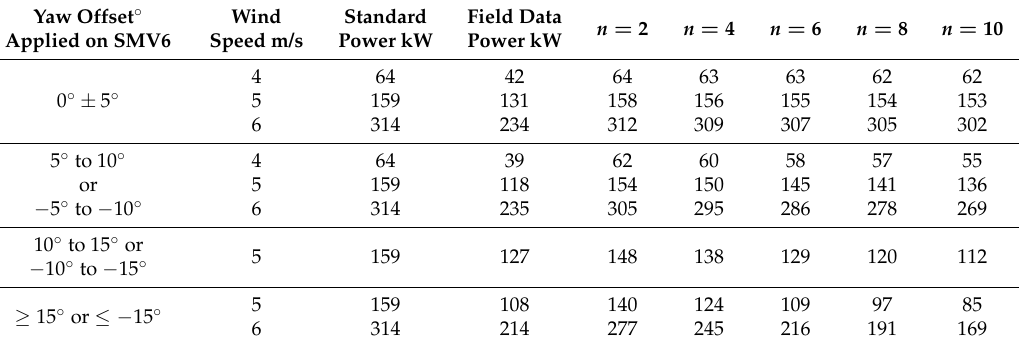
Table 5. Quantifying impact of yaw offset on SMV6 power production using Equation